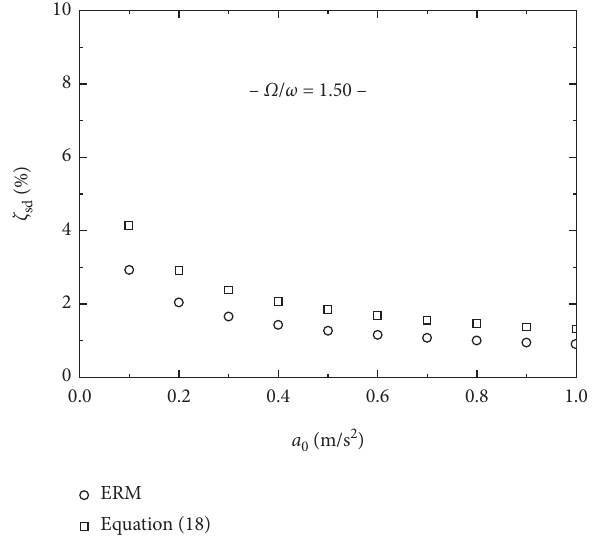
Figure 4: Comparison of the ADRs calculated using the two methods with different excitation amplitudes ( Ω / ω �